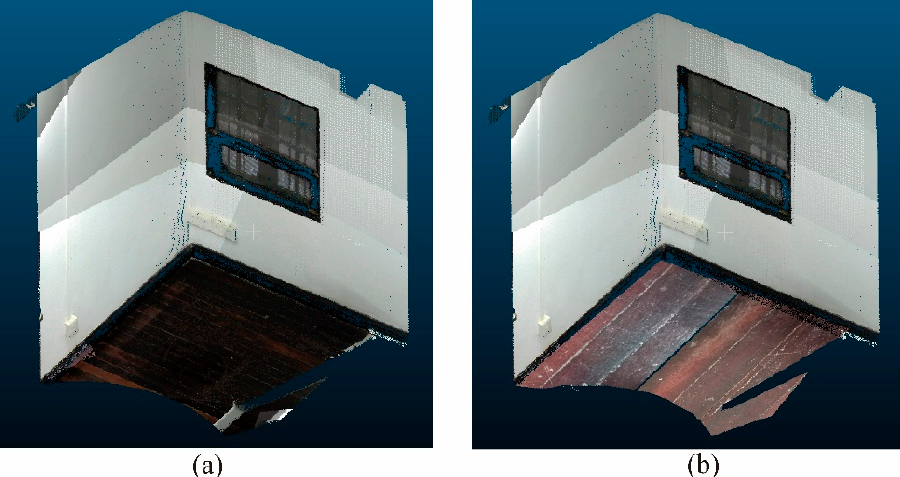
Figure 16. Point cloud of a corner of the Wesley House: ( a ) the original registered point cloud; ( b ) registered point cloud after the proposed colorization method is applied.